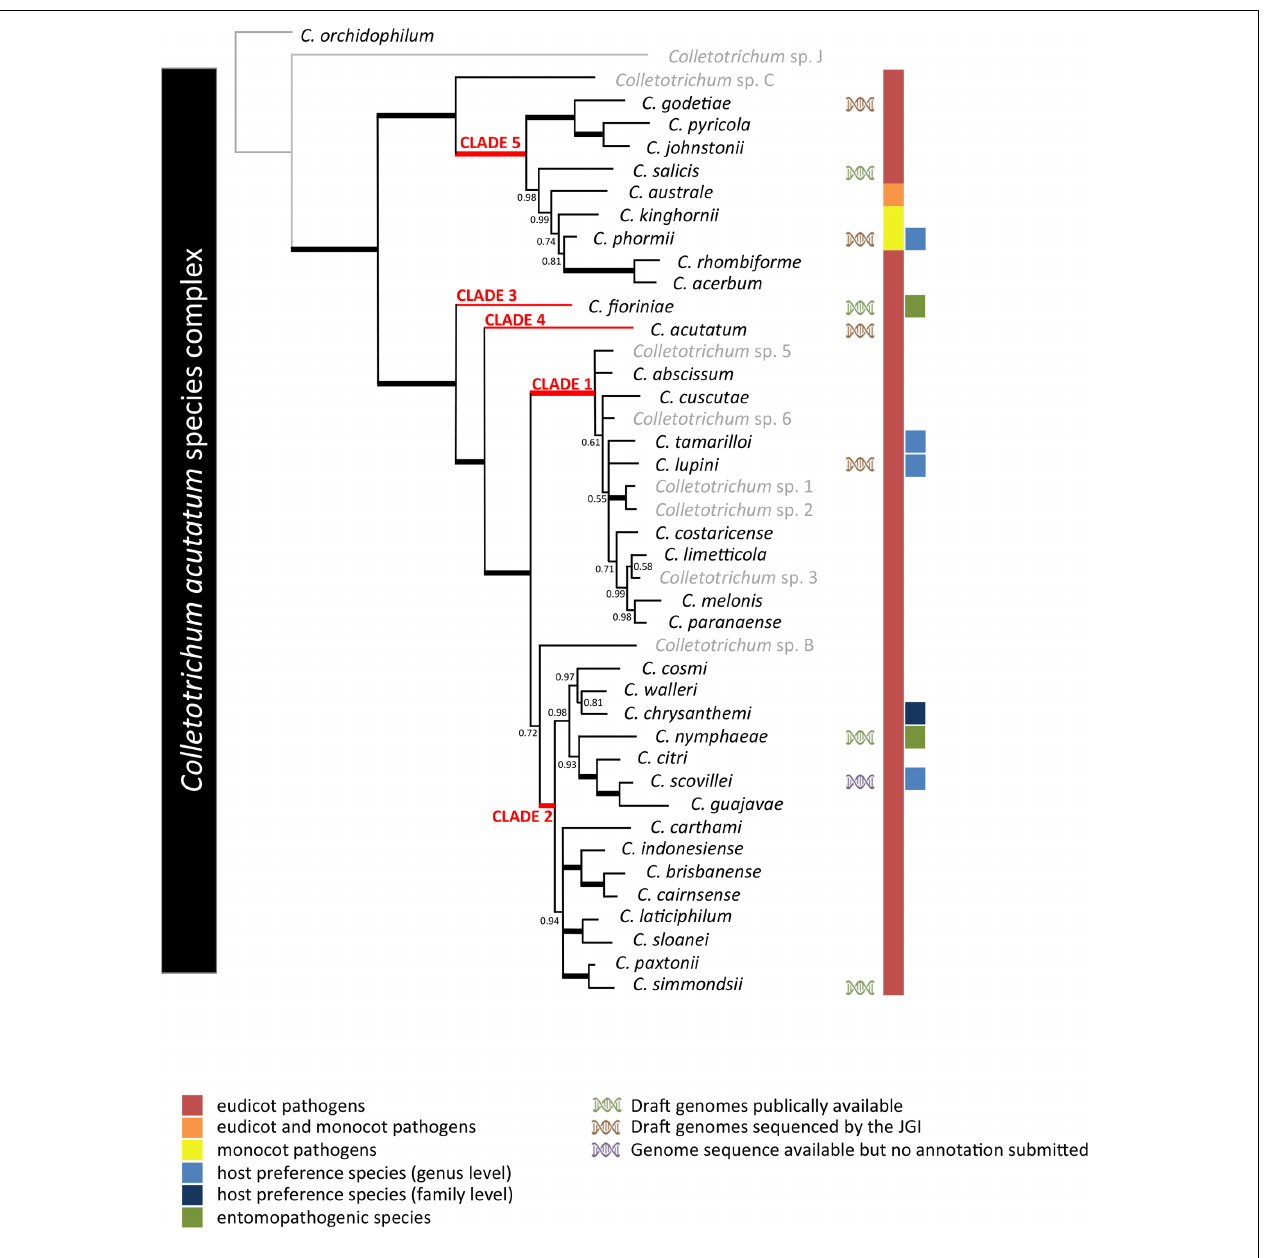
FIGURE 1 | Phylogenetic analysis of the 42 Colletotrichum acutatum species complex strains listed in Supplementary Table S1 based on a multilocus concatenated alignment of the ITS, GAPDH, CHS-1, HIS3, ACT, and TUB2 genes. Accepted species (Jayawardena et al., 2016) are highlighted in black while isolates not fitting with those are reported in gray. Colletotrichum orchidophilum was used as an outgroup.